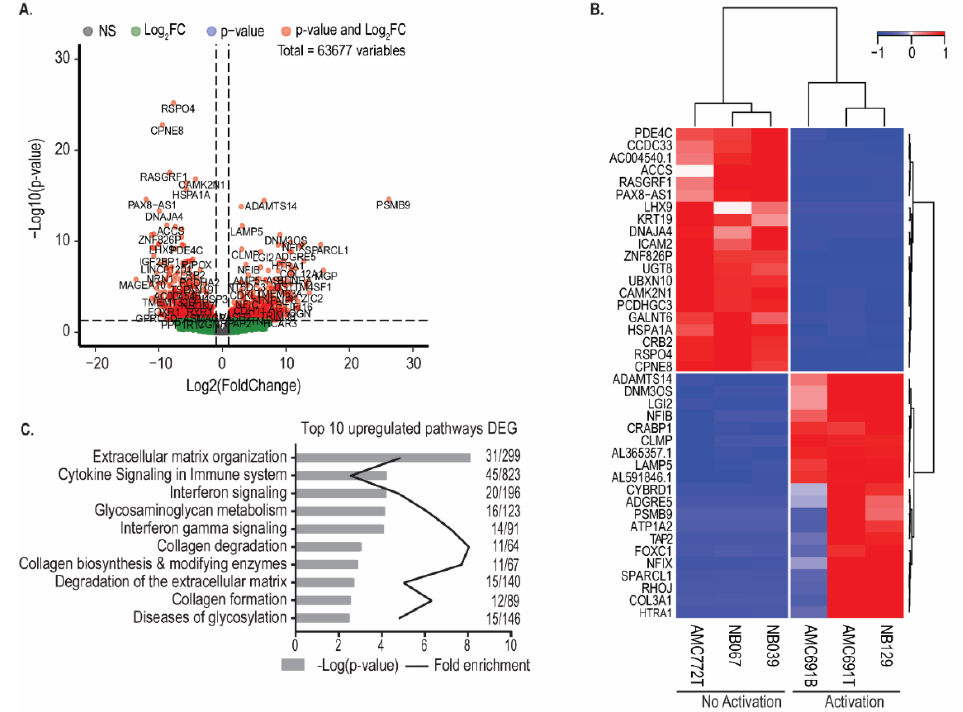
Figure 3. Organoids that activate TEG002 have a distinct transcriptomic profile. ( A ) Volcano plot of significantly differentially expressed genes between organoids that activated TEG002 and those that did not. ( B ) Heatmap of top 20 upregulated and top 20 downregulated genes. Expression values were scaled and centered. Clustering with Euclidian distance and Ward’s method. ( C ) Reactome pathway analysis of significantly upregulated genes in organoids that activated TEG002. Bonferroni-correct p -values are shown.